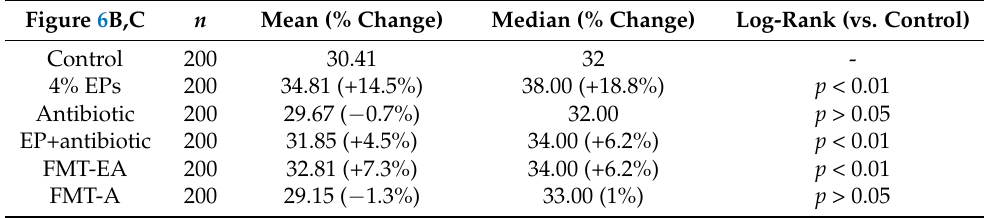
Table 3. Statistics of survival curves in Figure 6. Cohort sizes, mean and median life spans, percentage changes, and log-rank tests of the Kaplan–Meier survival curves in this